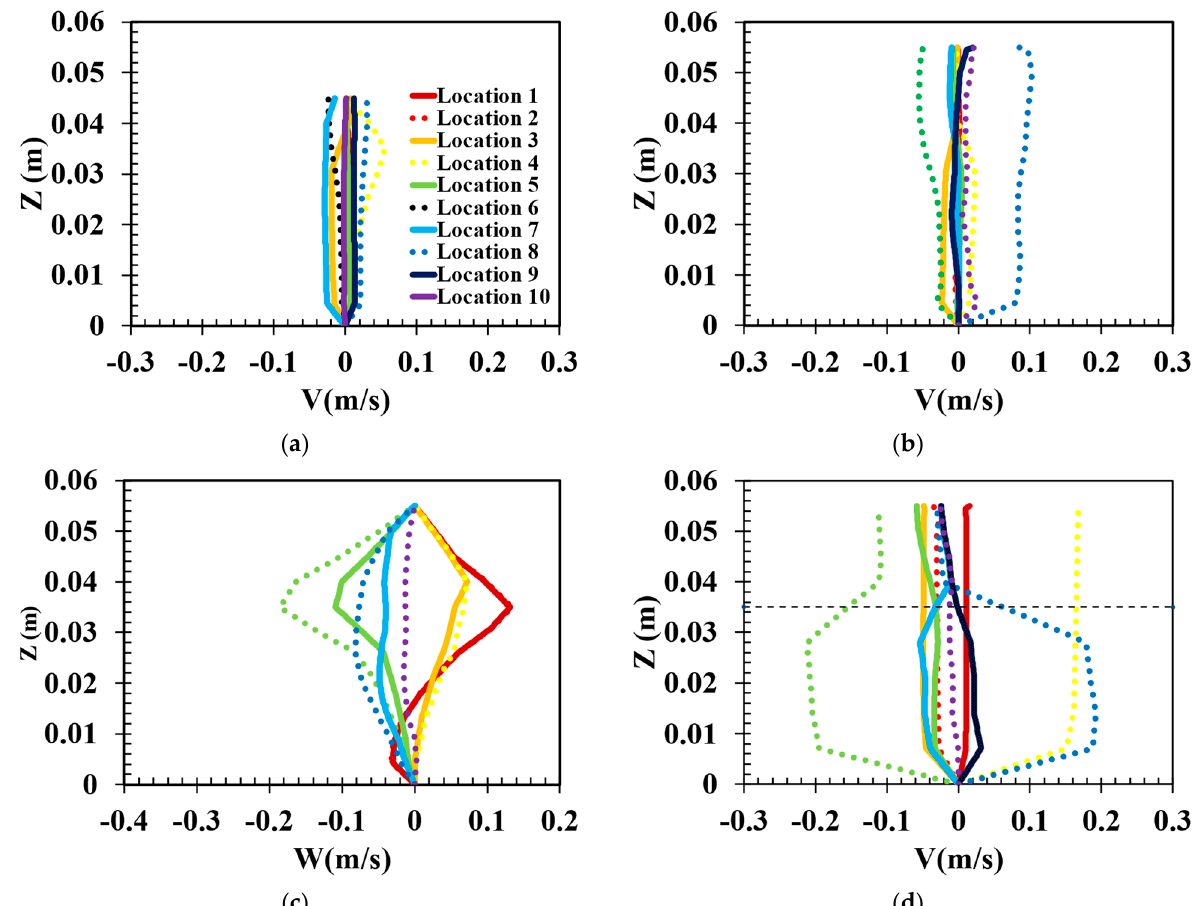
Figure 6. ( a – d ) The simulated results of the lateral velocity profiles ( v ) at specified locations: ( a ) case 1; ( b ) case 2; ( c ) case 3; ( d ) case 4. 1; ( b ) case 2; ( c ) case 3; ( d ) case